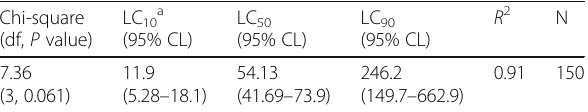
Table 5 LC 10 , LC 50, and LC 90 values for Steinernema carpocapsae IRMoghan against Agrotis segetum Chi-square (df, P value)